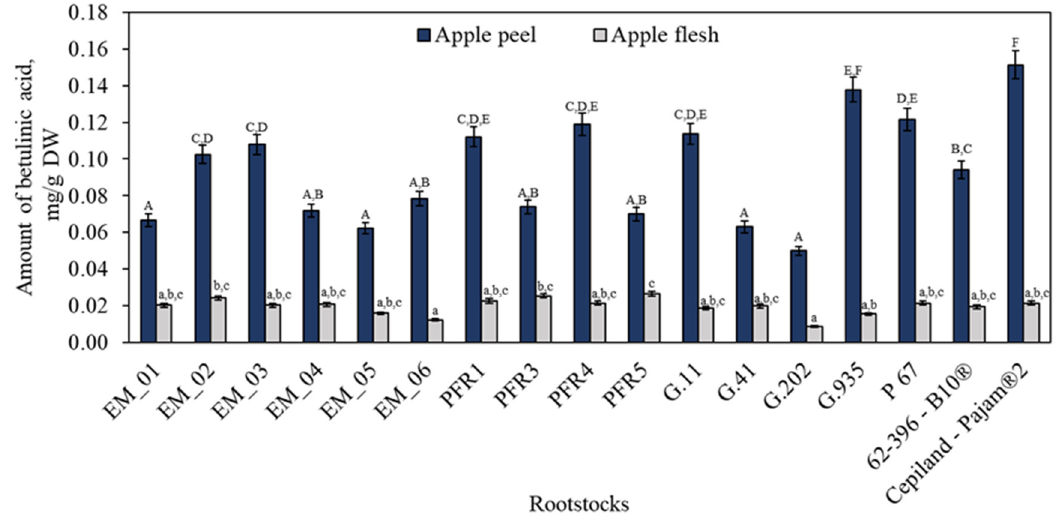
Figure 5. Influence of rootstocks on the quantitative composition of betulinic acid. The means followed by different uppercase and lowercase letters are significantly different at p < 0.05.